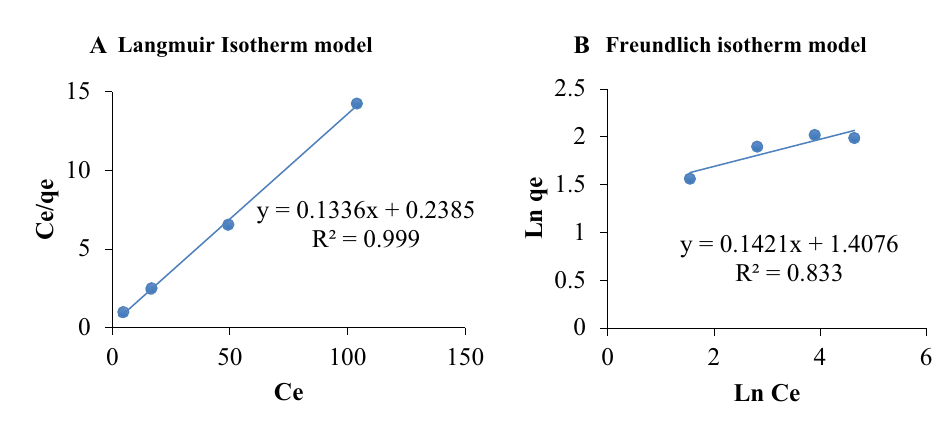
Table 8 Optimum conditions of the four studied parameters for removal of Cr(VI) by THAC Process parameters pH Initial conc. of Cr(VI) Dose of AC Contact time Removal efficiency Desirability Optimized condition 1.92 87.83 mg/L